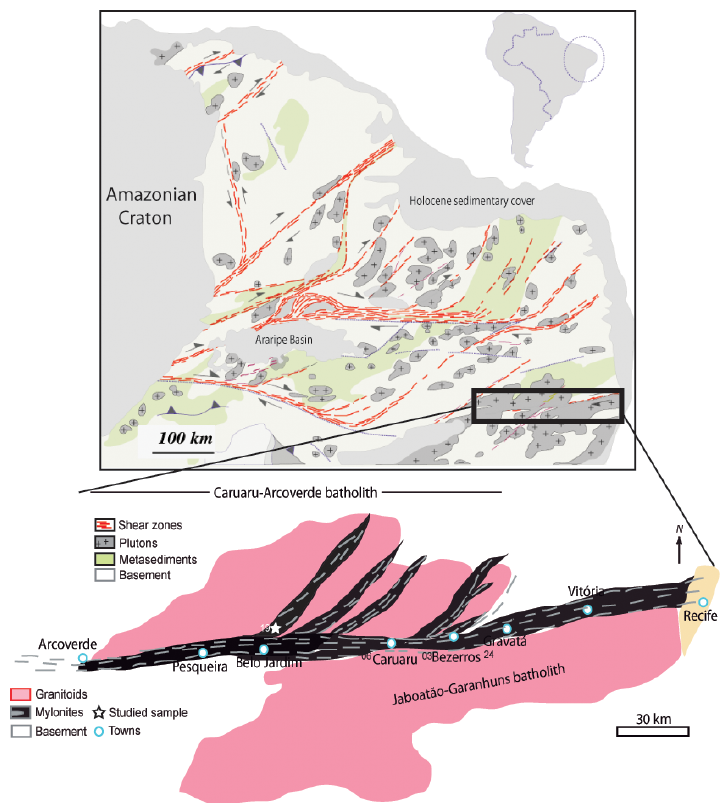
Figure 1. Geological setting of the Borborema Province, location of the Pernambuco shear zone (inset) and the sample chosen for this study (star symbol on the